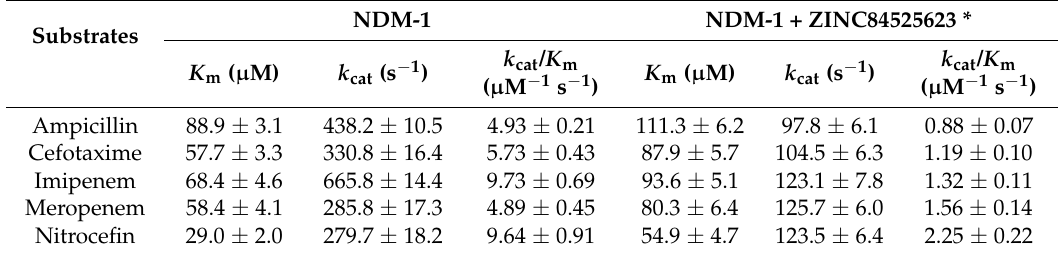
Table 5. The steady-state enzyme kinetics of NDM-1 in the presence and absence of inhibitor ZINC84525623.